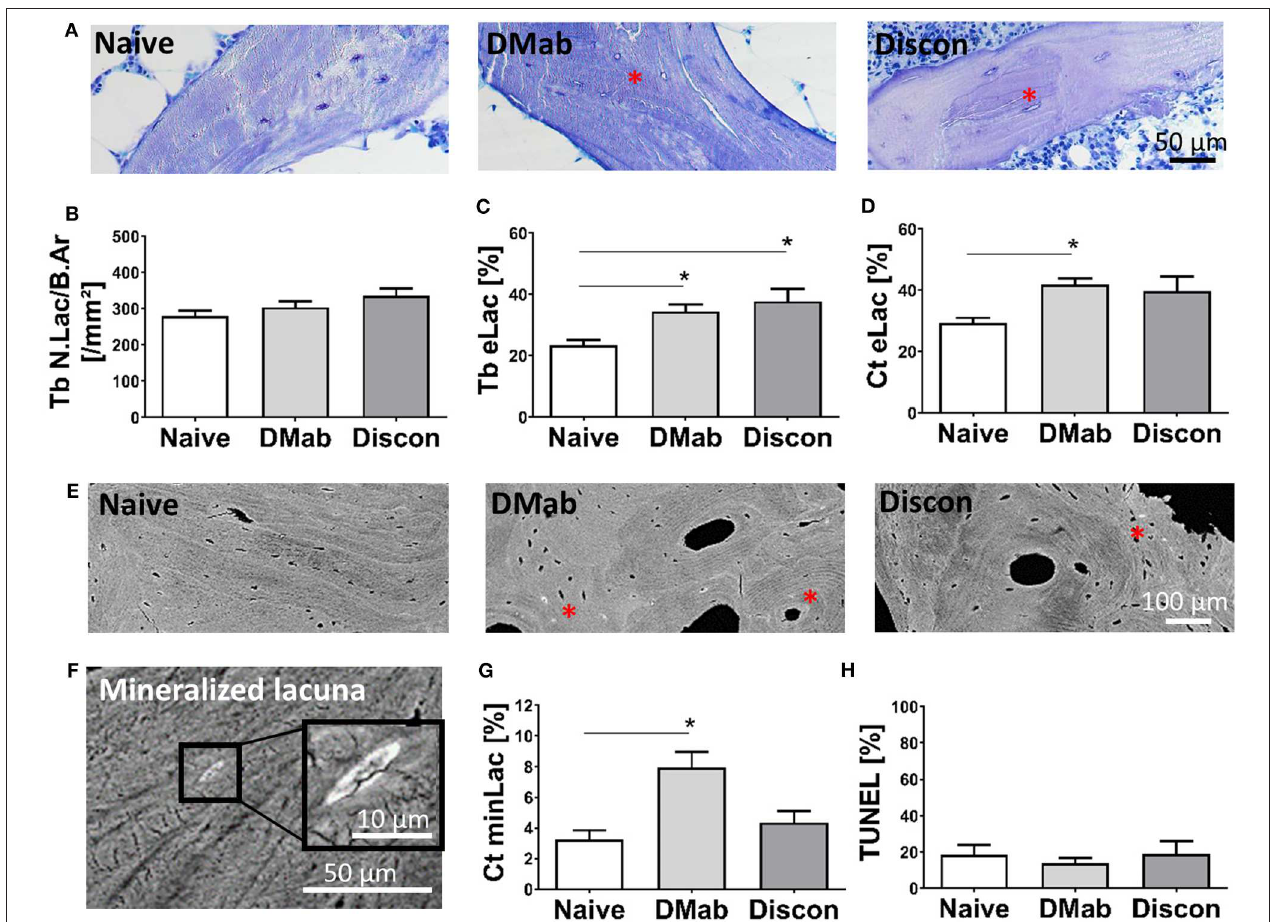
FIGURE 5 | Osteocyte network characteristics. (A) Representative toluidine blue stained histological images of trabecular bone. Viable osteocyte lacunae with cell nuclei are evident before denosumab treatment initiation. Red asterisks designate areas of empty osteocyte lacunae not only during denosumab treatment DMab but also after treatment cessation. (B) Quantification of total number of lacunae in trabecular bone per bone area (Tb N.Lac/B.Ar) and (C) number of empty lacunae without cell nuclei in trabecular bone (Tb eLac; shown in percent). (D) Number of empty lacunae in cortical bone. (E) High-Resolution backscattered scanning electron microscopy imaging enables the identification of osteocyte lacunae subject to mineralization (i.e., micropetrosis) in cortical bone (red asterisks). (F) High magnification reveals lacunar occlusion with mineral. The lacunar occlusion represents the endpoint of prior osteocyte death accompanied by the growth and fusion of apoptotic bodies. (G) Micropetrotic lacunae were predominantly found (Ct minLac) in cortical bone when treated with denosumab, while treatment discontinuation showed a return to characteristics compatible with the treatment-naive status, where less occlusion of osteocyte lacunae was evident. (H) Percentage of apoptotic osteocytes in cancellous bone assessed by TUNEL assay did not vary between the groups. Graphs show mean and standard error of the mean (SEM). Statistical analyses were performed using one-way ANOVA and Tukey post hoc test. * p <